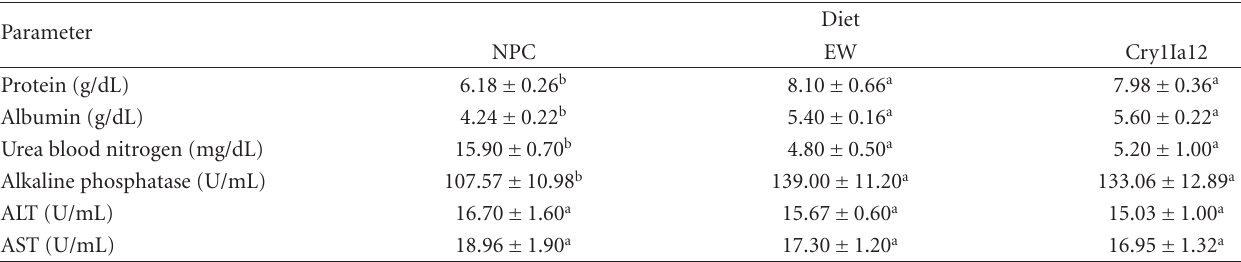
Table 4: Blood biochemical parameters of rats fed the nonprotein (NPC), egg white (EW), and test (Cry1Ia12) diets.